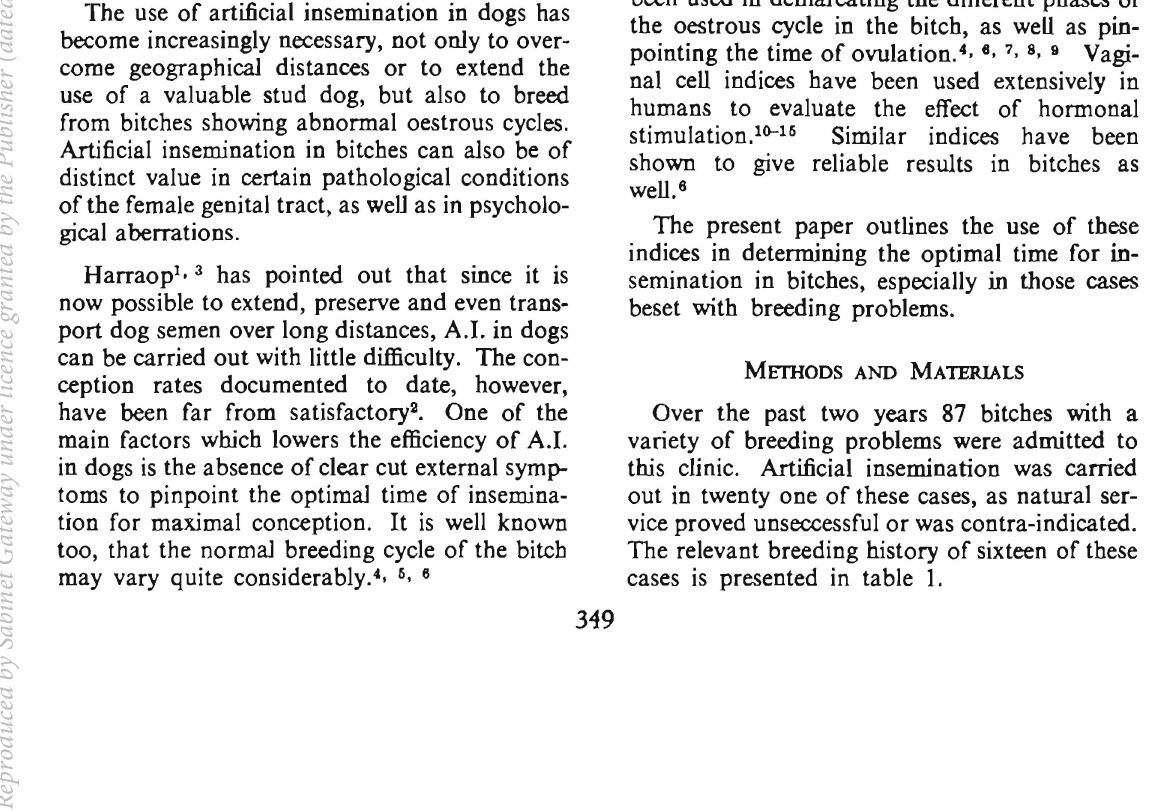
Fig. 1. - The typical picture of a vaginal smear taken during oestrum, characterised by a predomin ence of large keratinised squamous cells. The darker staining cells (a) are eosinophilic while the llghtly stained cells (b) are